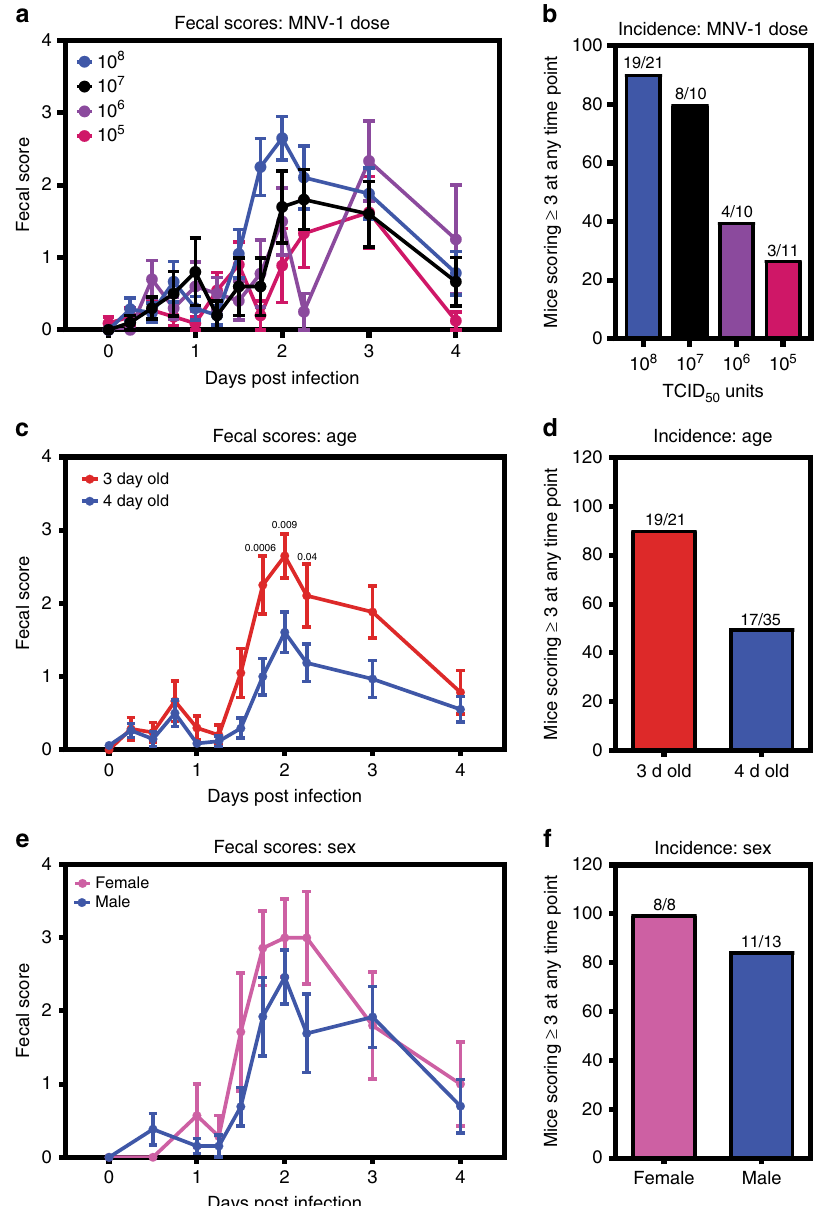
Fig. 2 Dose, host age, and sex in fl uence MNV disease severity in neonatal mice. a Groups of 3-day-old BALB/c pups were infected with 10 8 ( n = 21, blue), 10 7 ( n = 10, black), 10 6 ( n = 10, purple), or 10 5 ( n = 11, pink) TCID 50 units of MNV-1 by oral gavage and monitored for fecal consistency by palpating their abdomens. b The proportion of mice scoring a 3 or 4 at any time point over the 5 days course of infection is presented as the incidence of diarrhea. c , d Data strati fi ed by age from groups of 3- and 4-day-old BALB/c pups ( n = 21 for 3-day old (red) ; n = 35 for 4-day old (blue)) infected with 10 8 TCID 50 units of MNV-1 by oral gavage and monitored for fecal inconsistency. Data presented as fecal scores over time ( c ) and incidence ( d ). e , f Data strati fi ed by sex ( n = 8 for female (pink); n = 13 for male (blue)) from groups of 3-day-old BALB/c pups infected with 10 8 TCID 50 units of MNV-1 by oral gavage and monitored for fecal inconsistency. Data presented as fecal scores over time ( e ) and incidence ( f ). Error bars denote standard errors of mean in all fi gures. P values were determined using two-way ANOVA with corrections for multiple comparisons. Source data are provided as a Source data fi